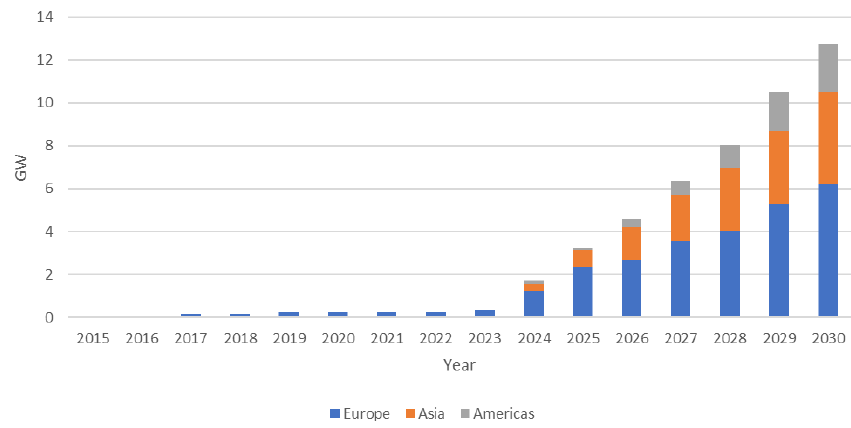
Figure 4. Floating offshore wind market outlook. Adapted from [34].